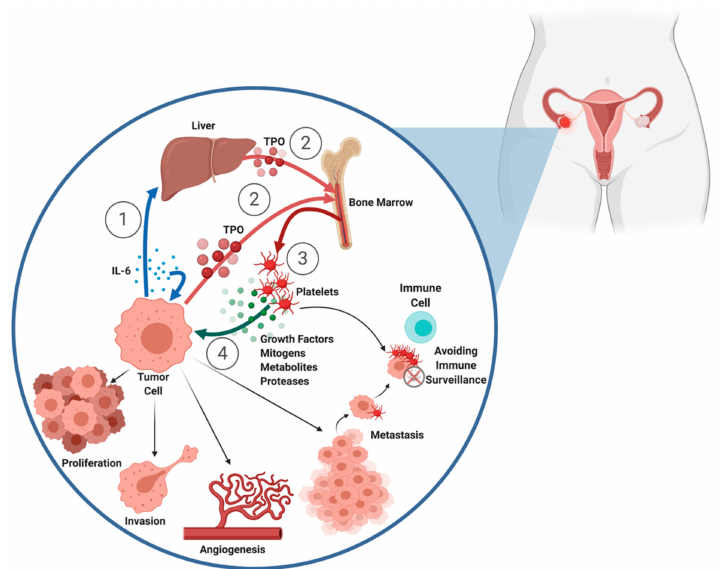
Figure 1. Contributions of platelets to ovarian cancer progression. ( 1 ) Tumor cells produce the cytokine interleukin-6 (IL-6). ( 2 ) IL-6 drives production of thrombopoietin (TPO) directly from tumor cells as well as the liver. ( 3 ) TPO stimulates production and release of platelets from bone marrow. ( 4 ) Platelets support cancer cell proliferation, invasion, angiogenesis, migration, and metastasis through release of growth factors, mitogens, metabolites, and proteases. They may also act as sites of seeding